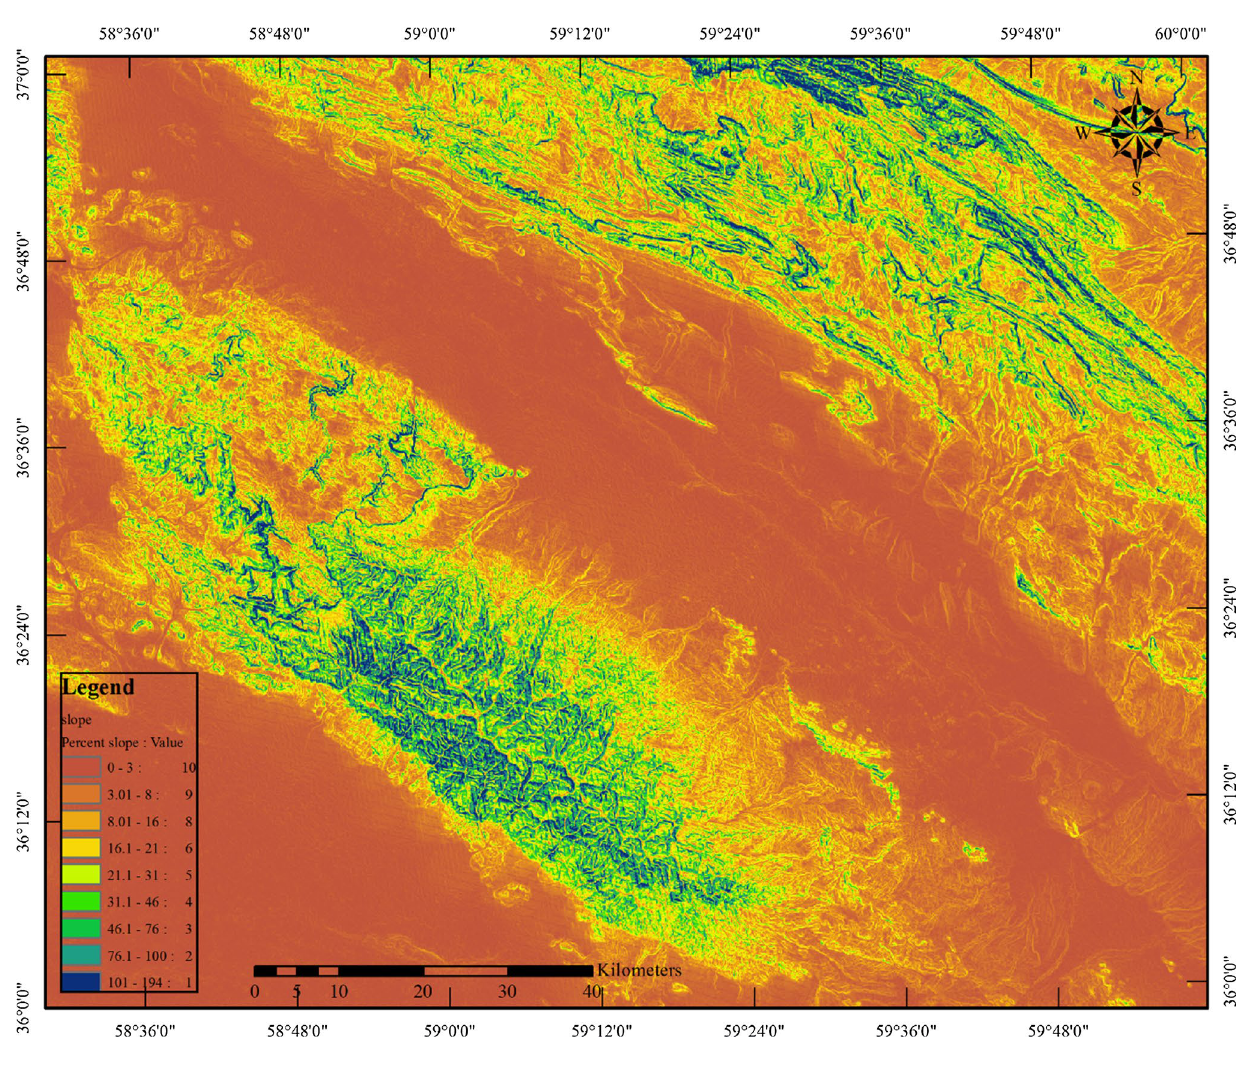
Fig. 4 Slope map and scoring Table 3 The lithology variable and scoring of this